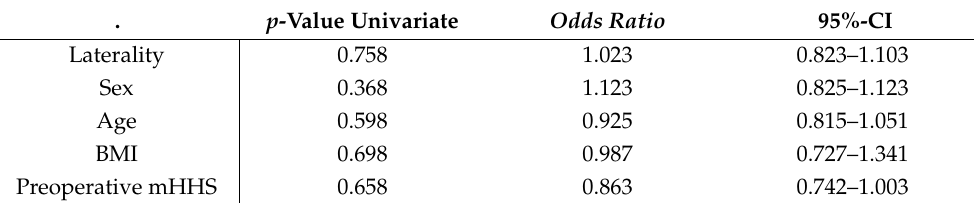
Table 2. Logistic Regression Analysis of Preoperative Variables Associated with Achieving PSQI < 5.